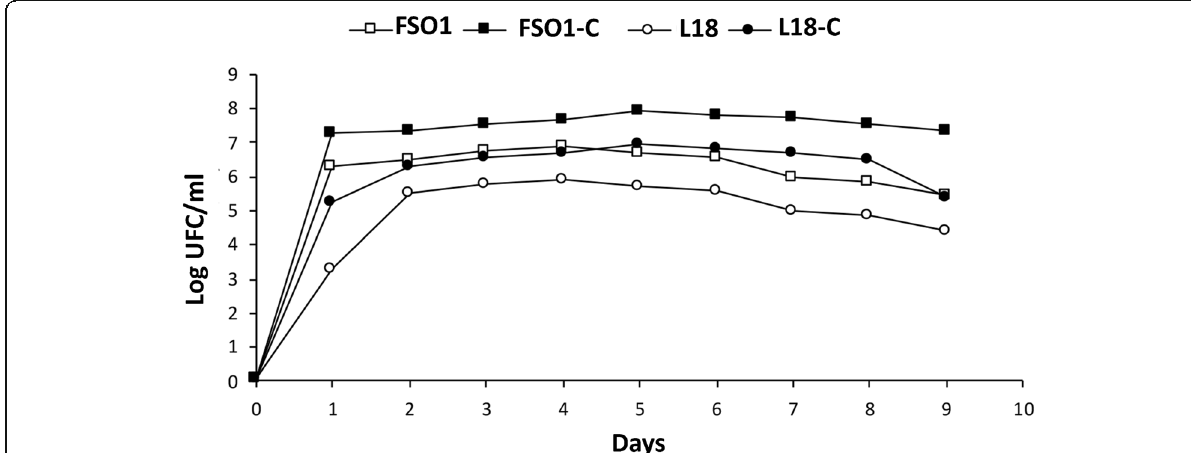
Fig. 7 Evolution of biomass growth of FSO1 and L18 in pure cultures and combined culture (FSO1-C, L18-C) in modified MRS medium (Legend: FSO1: L. plantarum , L18: C. pelliculosa , FSO1-C: FSO1 in FSO1/L18, L18-C: L18 in FSO1/L18)